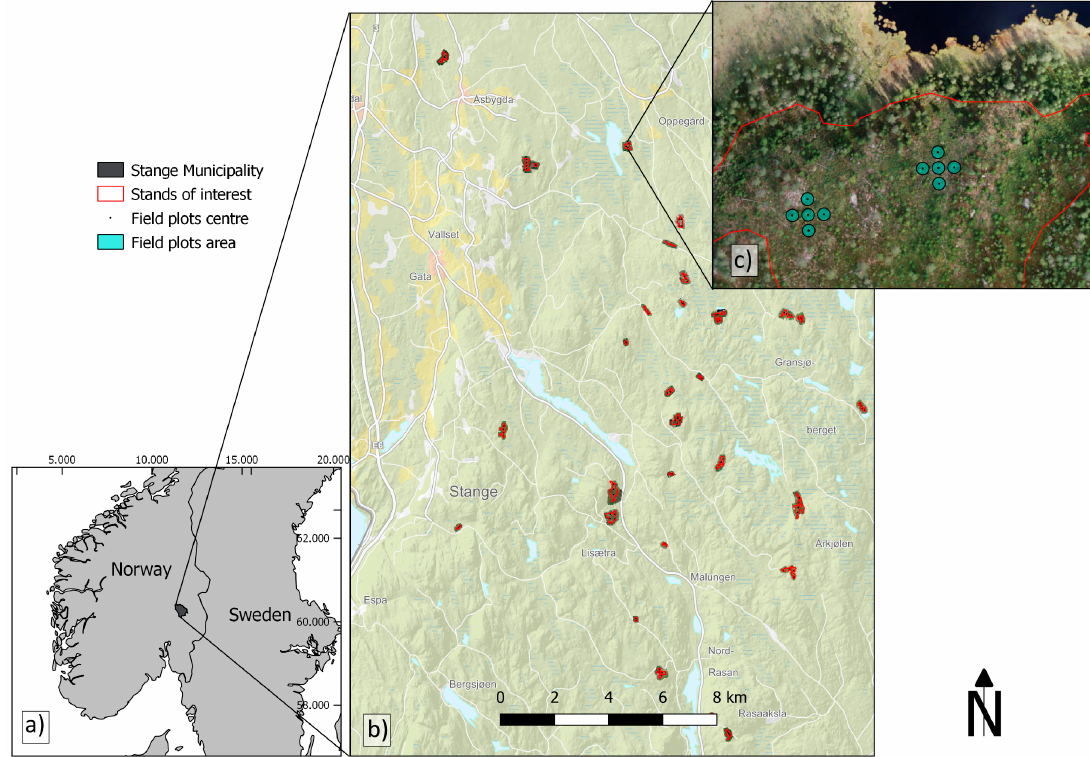
Figure 1. Overview of the study area including: ( a ) the location within Norway, ( b ) the spatial distribution of the 29 stands under regeneration, and ( c ) details of the field sampling design for one of the stands. The coordinate reference system for the pane in the bottom left corner is WGS84.